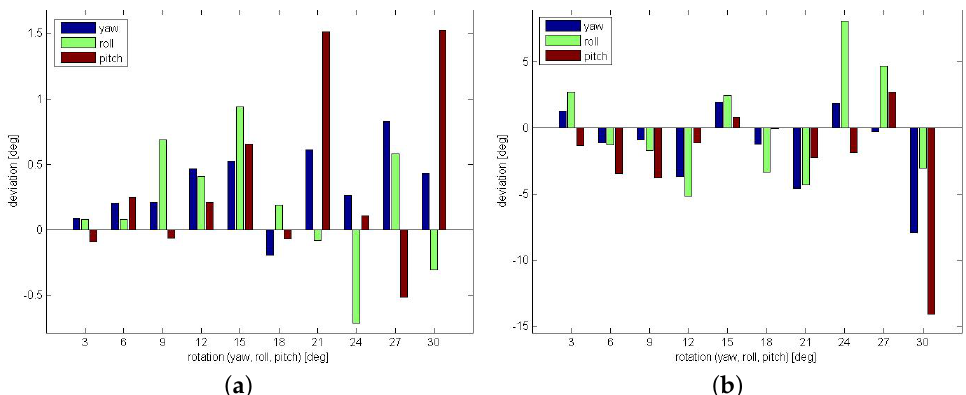
Figure 18. Evaluation of FMS and LF-FMS using artificial transformations and different scan types. For the angle accuracy a bandwidth of BW = 64 for the SOFT registration is used. The plots show the deviation from ground truth parameters in degrees. ( a ) FMS on MRT T1 and T2 scans. ( b ) LF-FMS on T1 MRT and PET